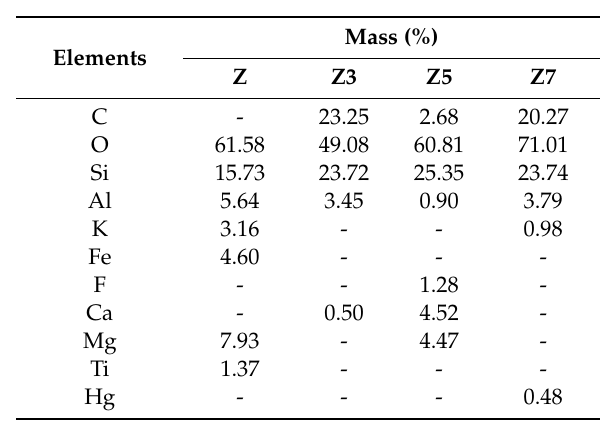
Table 1. Catalyst chemical compositions based on scanning electron microscope and energy-dispersive x-ray spectroscopy (SEM-EDX) data.